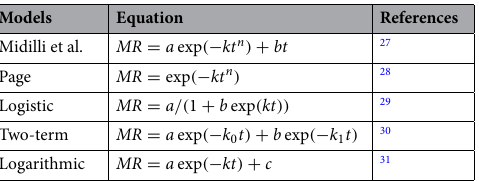
Table 1. Mathematical empirical drying models given by various authors for the drying